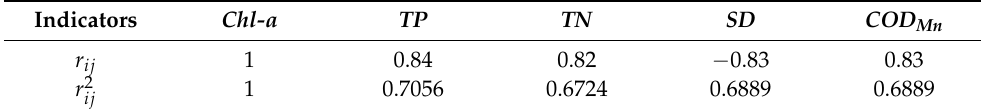
Table 1. r ij and r 2